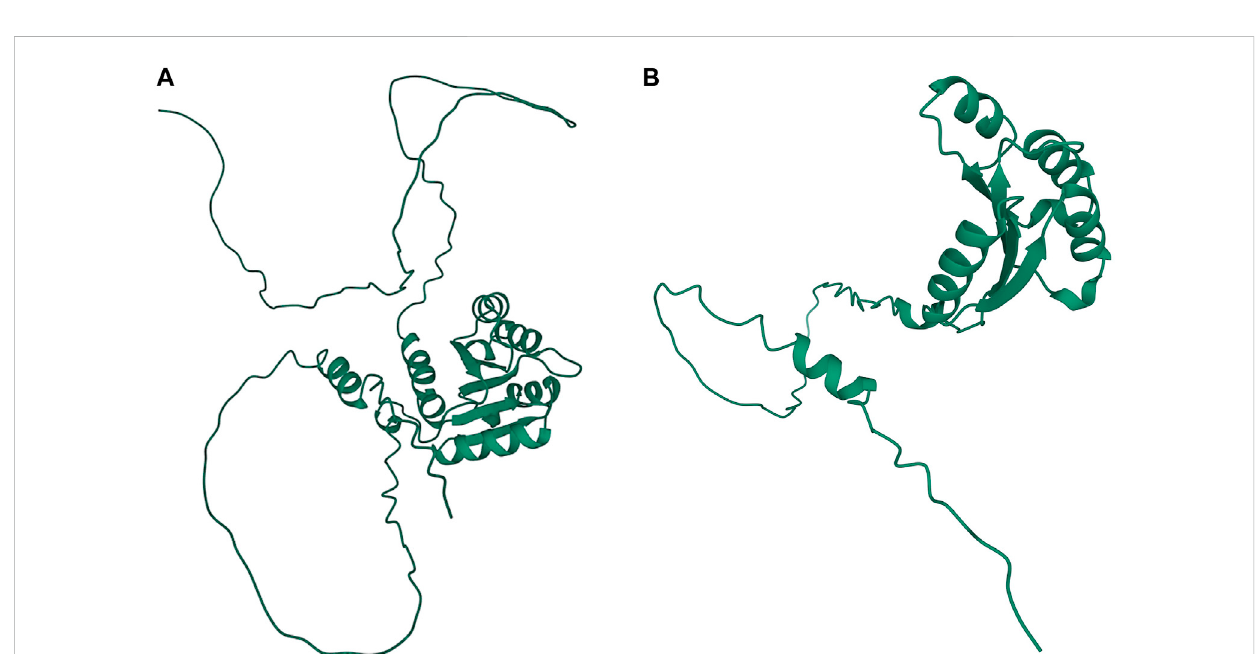
FIGURE 3 Protein structures predicted for Ma1 using AlphaFold two for both the (A) annotated protein and (B) truncated protein based on a single-base deletion at Chr06_40312436. Protein coils represent α helices and arrows represent β -pleated sheets.